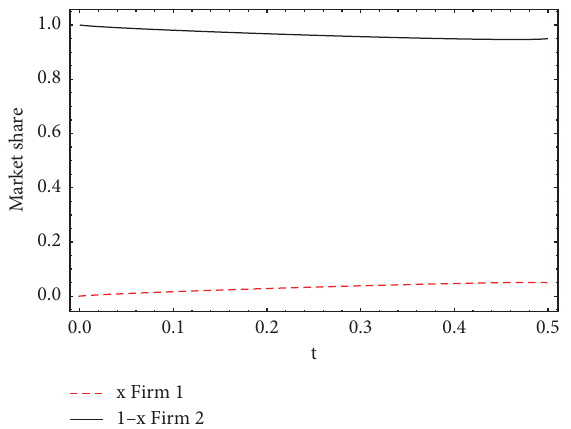
Figure 1: Market share of frm 1 and frm 2 at time t .